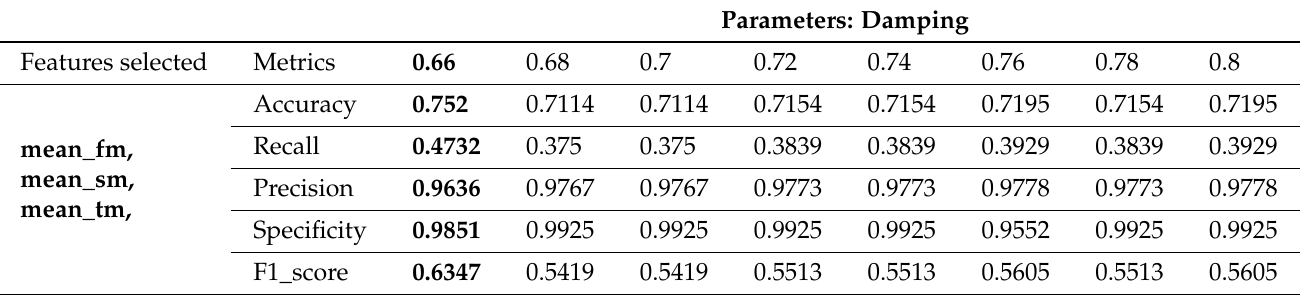
Table 16. Metrics, applying different configurations for Affinity propagation clustering—SVR. Parameters: